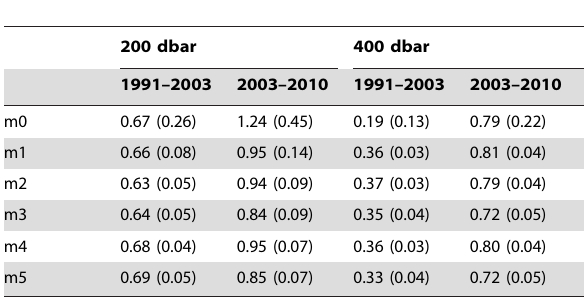
Table 6. Accumulation rates before and after the 3rd survey.